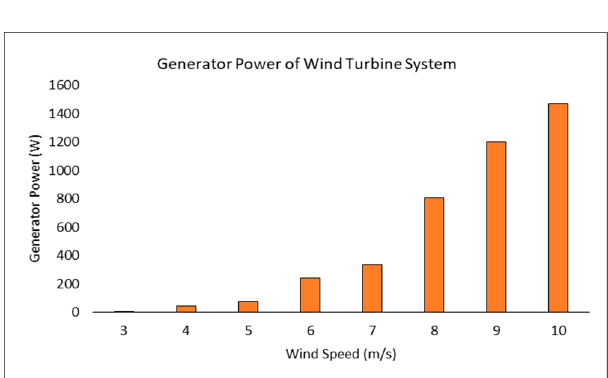
Table 8. Results of performance test of wind-turbine system.